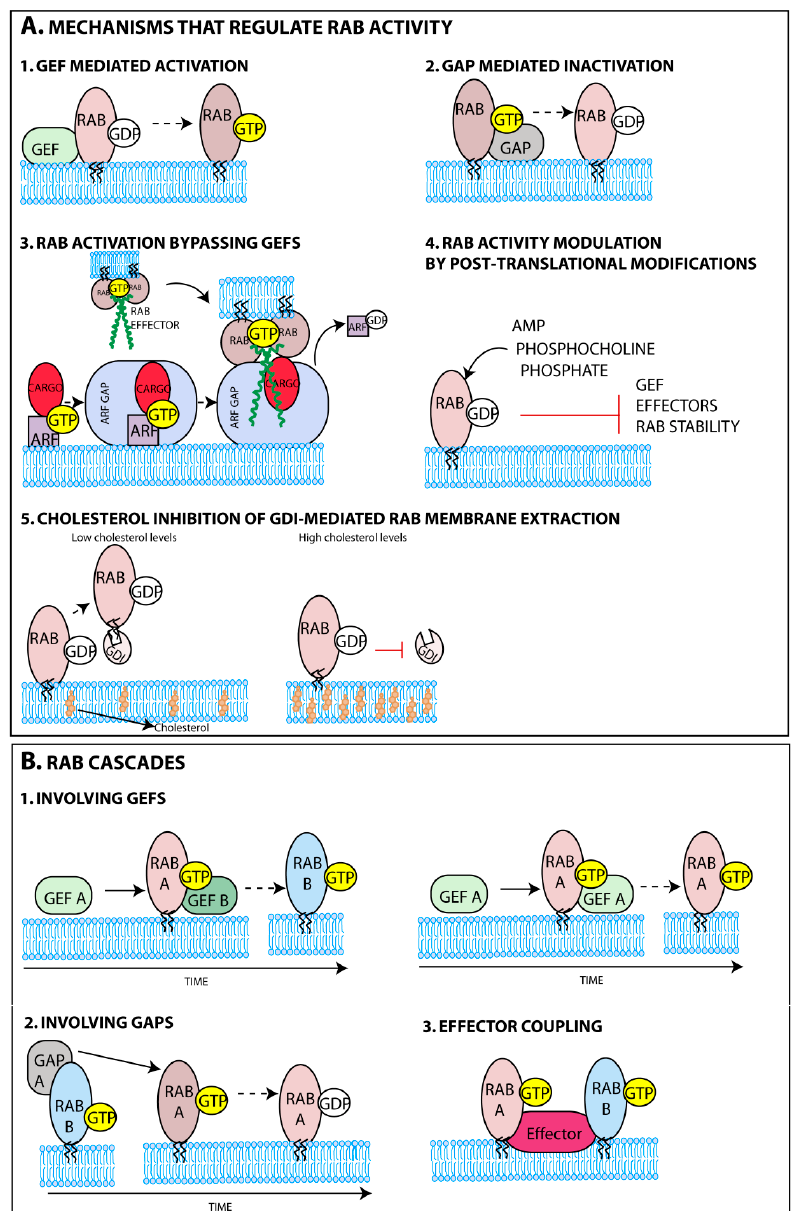
Figure 2. Rab GTPase spatial and temporal regulation. ( A ) Activation of Rab GTPases occurs through the exchange of GDP by GTP, a process catalyzed by guanine nucleotide exchange factors (GEFs), with a concomitant conformational change (1). Active Rabs attract multiple effectors and can be converted to the inactive state through GTP hydrolysis (2), which is accelerated by GTPase-activating proteins (GAPs). In certain circumstances, the recruitment of Rabs to membranes can bypass activation by Rab-GEFs. Activated ADP ribosylation factor (ARF) binds its cargo, and the dimer recruits the ARF GAP. The newly formed trimer has also affinity for an effector of a Rab, establishing a crosstalk between a ARF and a Rab (3). Alternatively, post-translational modifications can also regulate Rab function (4). High cholesterol content in membranes can reduce Rab extraction from membranes by inhibiting the activity of the corresponding guanine nucleotide dissociation inhibitory proteins (GDI) (5); ( B ) Rab GTPase conversion cascades are flexible mechanisms that allow crosstalk between Rabs. The activation (1) or inactivation (2) of a particular Rab can be made by a GEF or GAP, respectively, that was recruited by another Rab that acts upstream. The same Rab can also recruit its own GEF to maintain the activation state by positive feedback loop (1). Distinct Rabs can bind the same effector (3), a process called effector coupling.